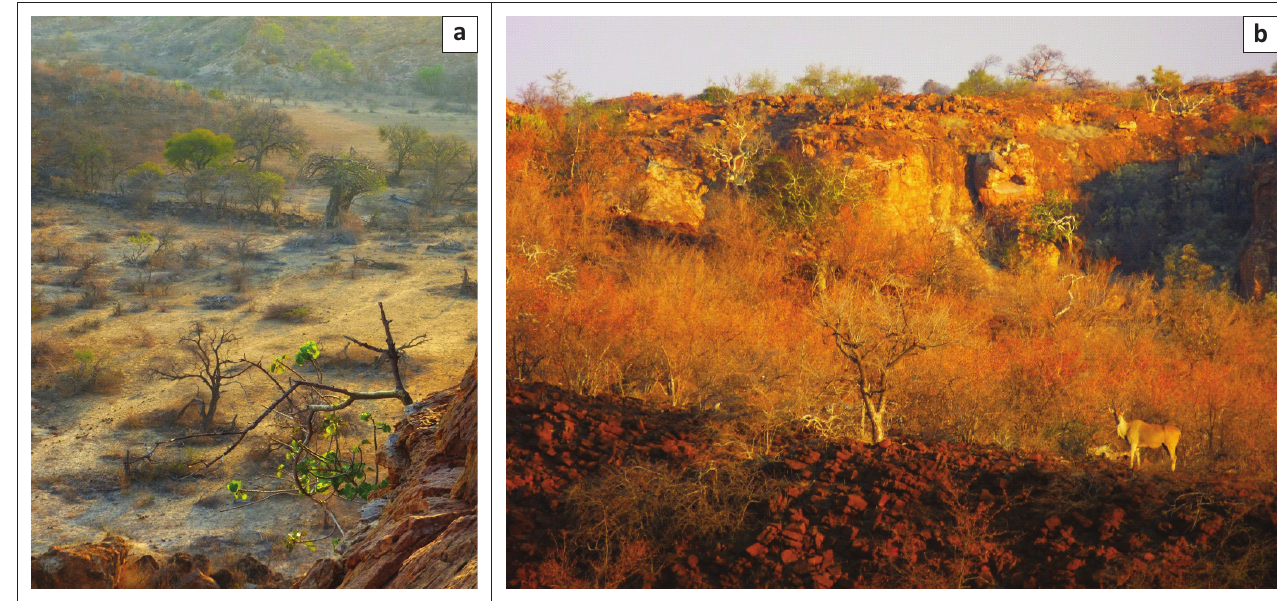
FIGURE 1-A1: Examples of typical (a) vegetation found on flats as opposed to (b) ridges in Mapungubwe National Park.